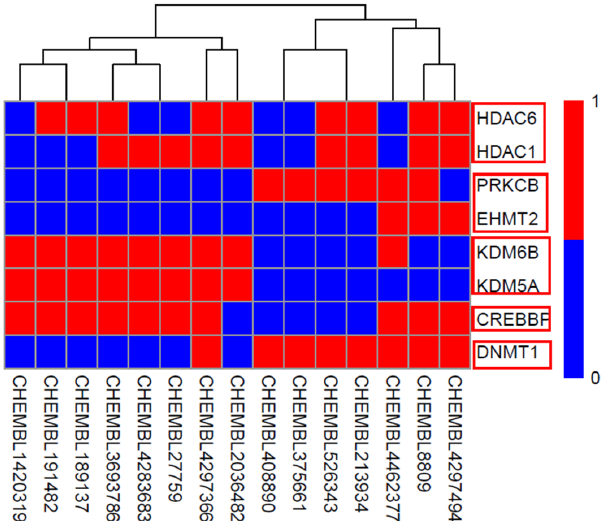
Figure 8. Prediction results of 15 new compounds that were not involved in the generation of our multiple models. The red box represented different objects, such as: DNMT, HDAC, and so on.